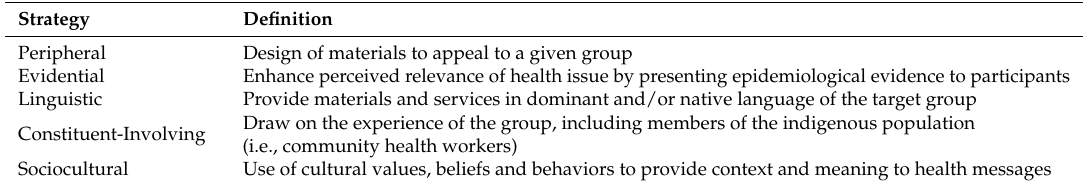
Table 1. Common strategies for enhancing cultural appropriateness